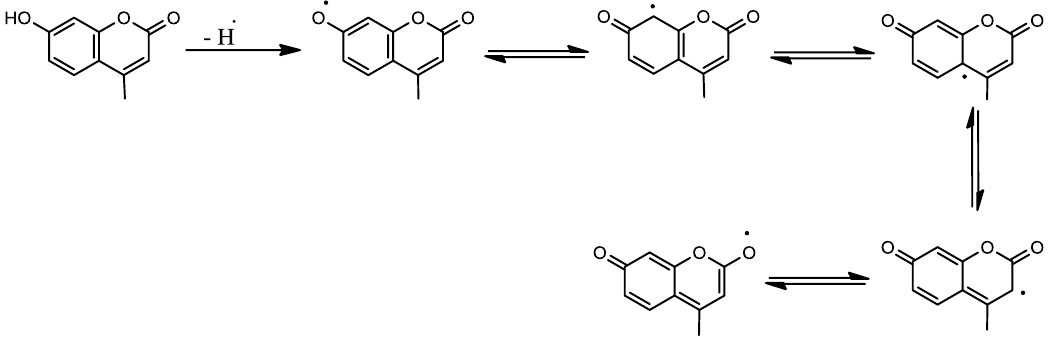
Figure 17. Resonance stability of phenoxy radical of 4-hydroxy coumarin (C 4 )